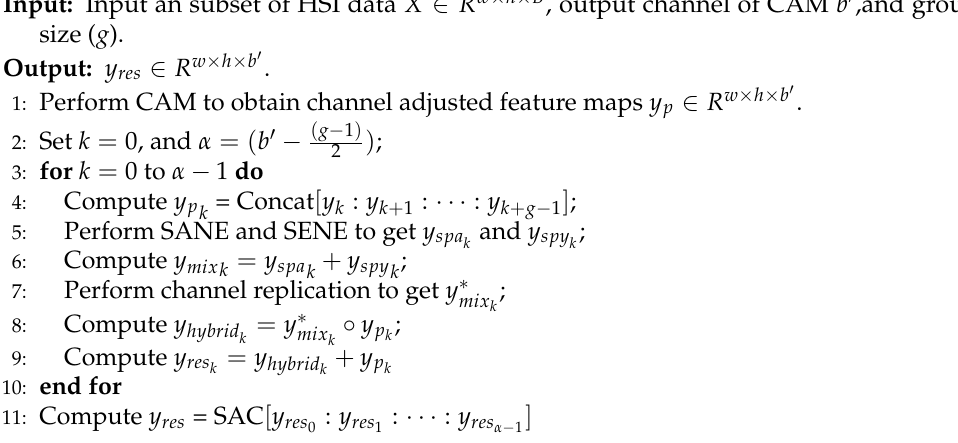
Algorithm 1 The Operation of CAM and